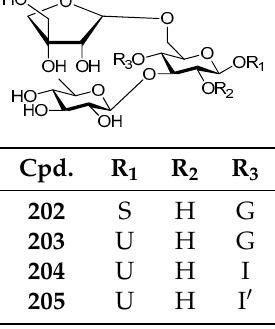
Figure 30. Structures of compounds 197 – 201 .